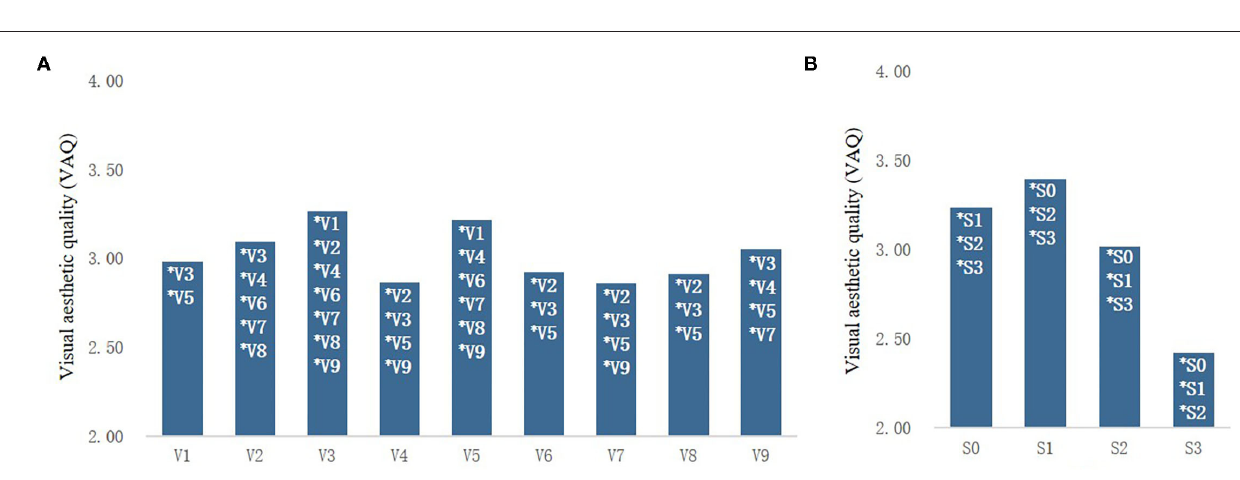
FIGURE 5 | Comparison of visual aesthetic quality (VAQ) for different street types (A) and different sound combinations (B)